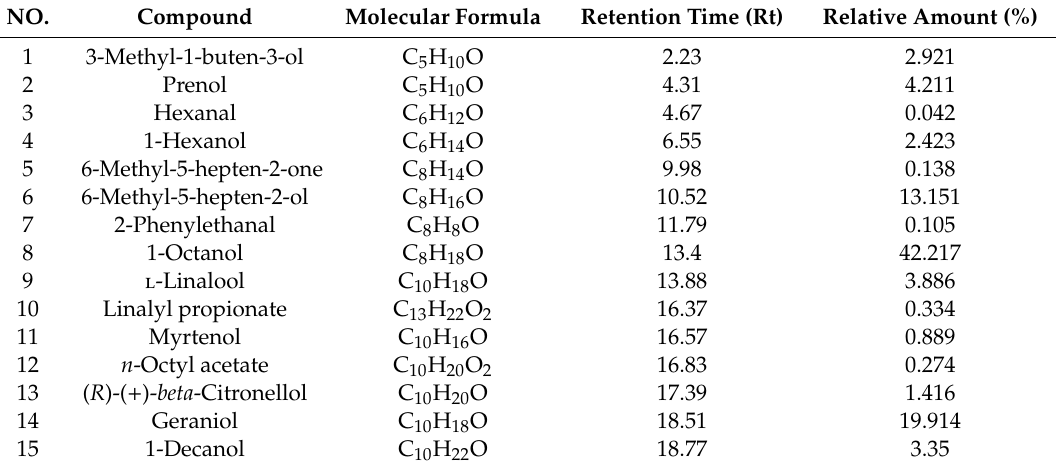
Table 1. Chemical composition of the essential oil of R. crenulata.